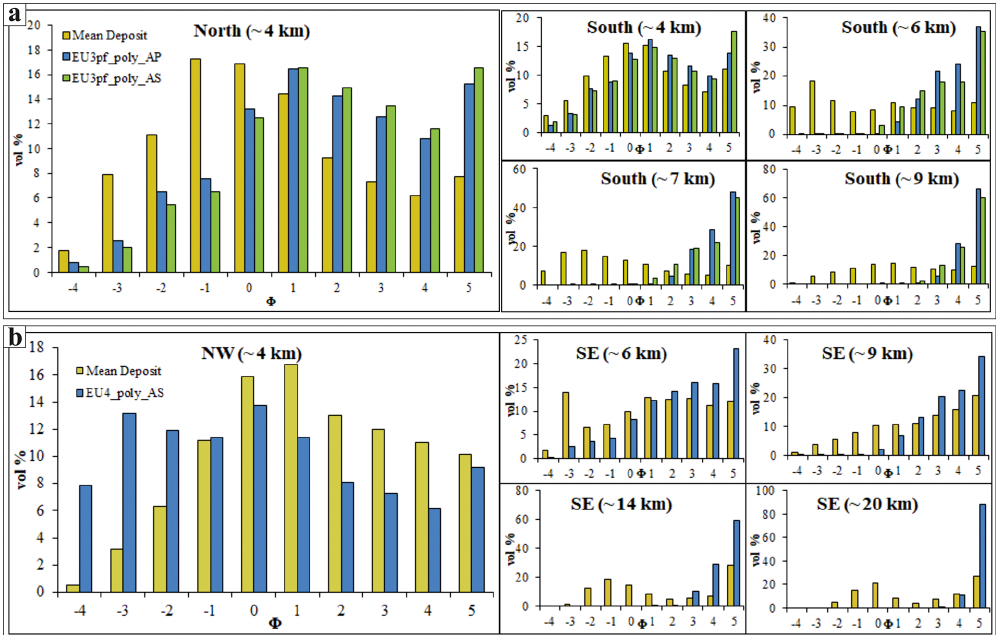
Figure 10. Comparison of volumetric grain sizes of the (a) EU3pf and (b) EU4b/c units. Different boxes concern different distances to the